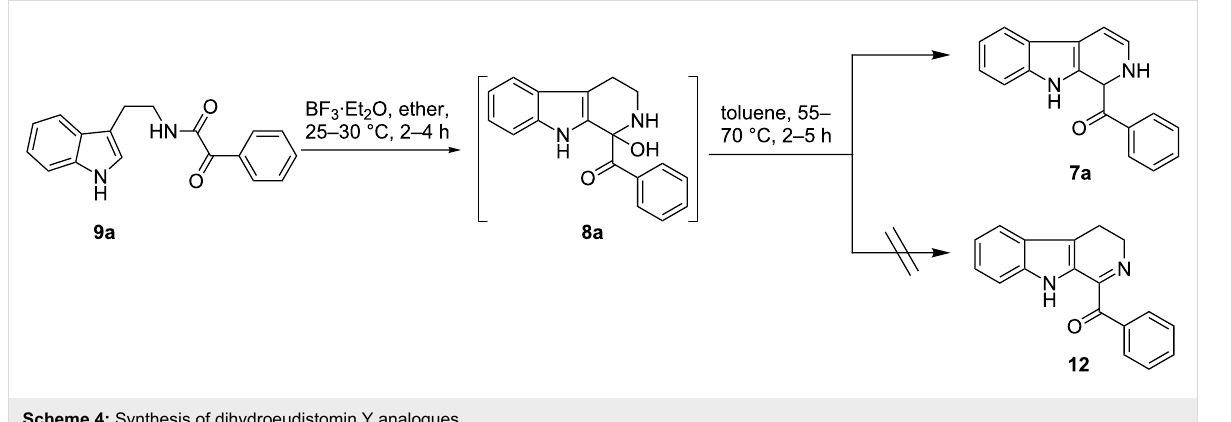
Scheme 4: Synthesis of dihydroeudistomin Y analogues.